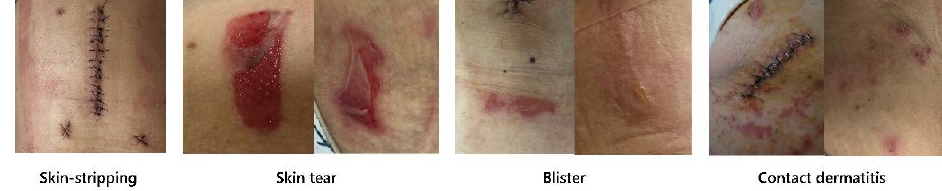
Figure 1. Different types of MARSI.